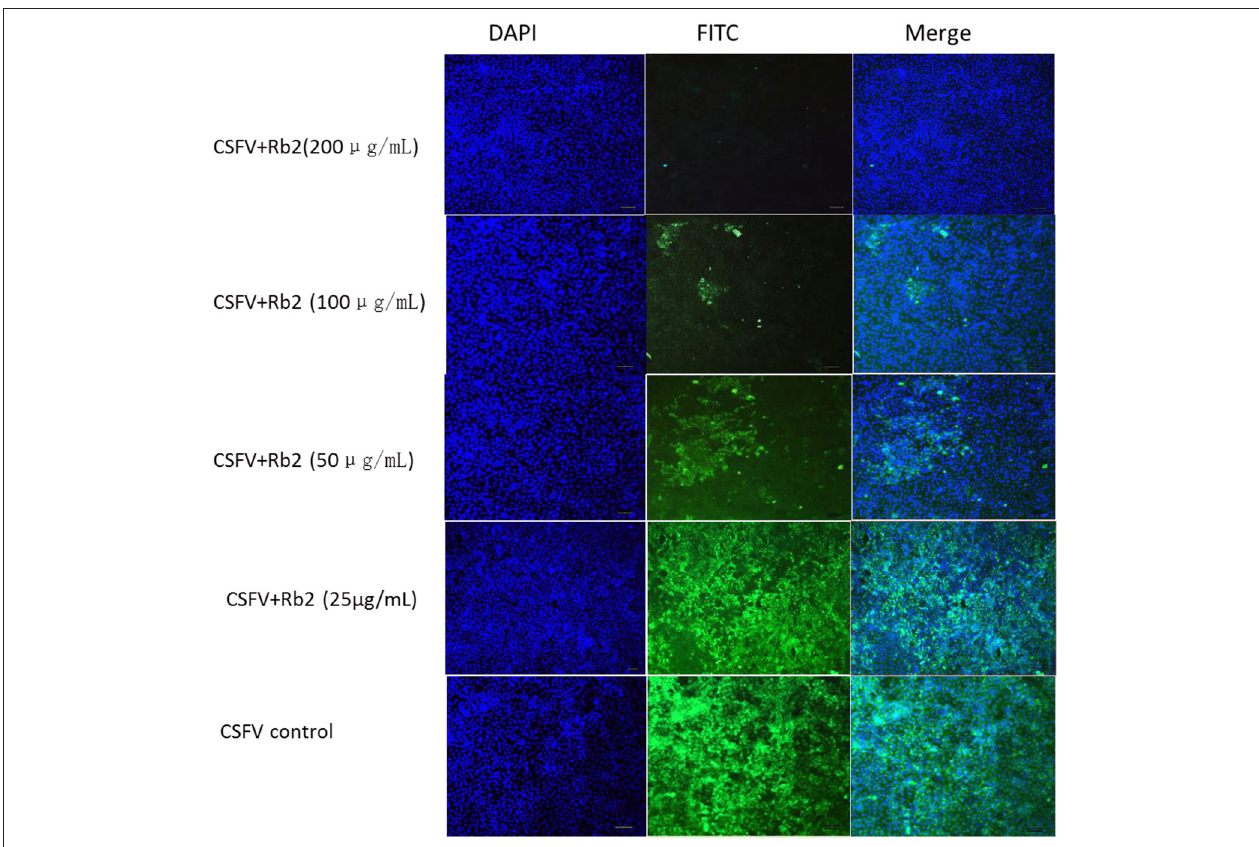
FIGURE 8 | The effect of Rb2 on CSFV Shimen with